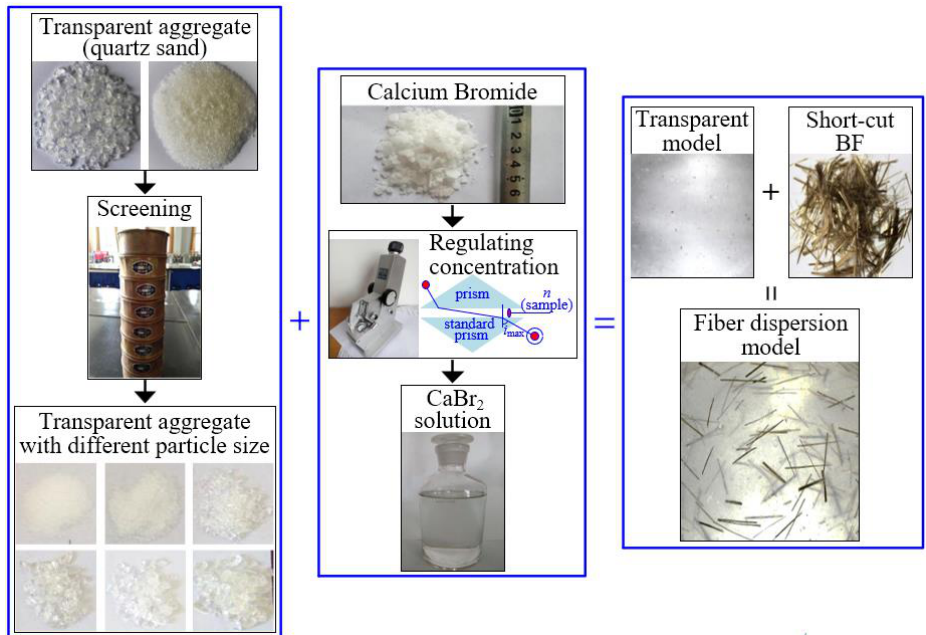
Figure 2. Schematic flow of transparent model